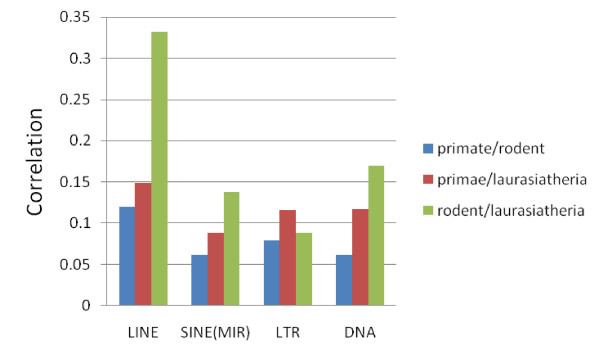
Rate correlations in four major repeat classes. LINEs have slightly higher correlations than other repeat classes, likely because a number of them are under selective pressures.